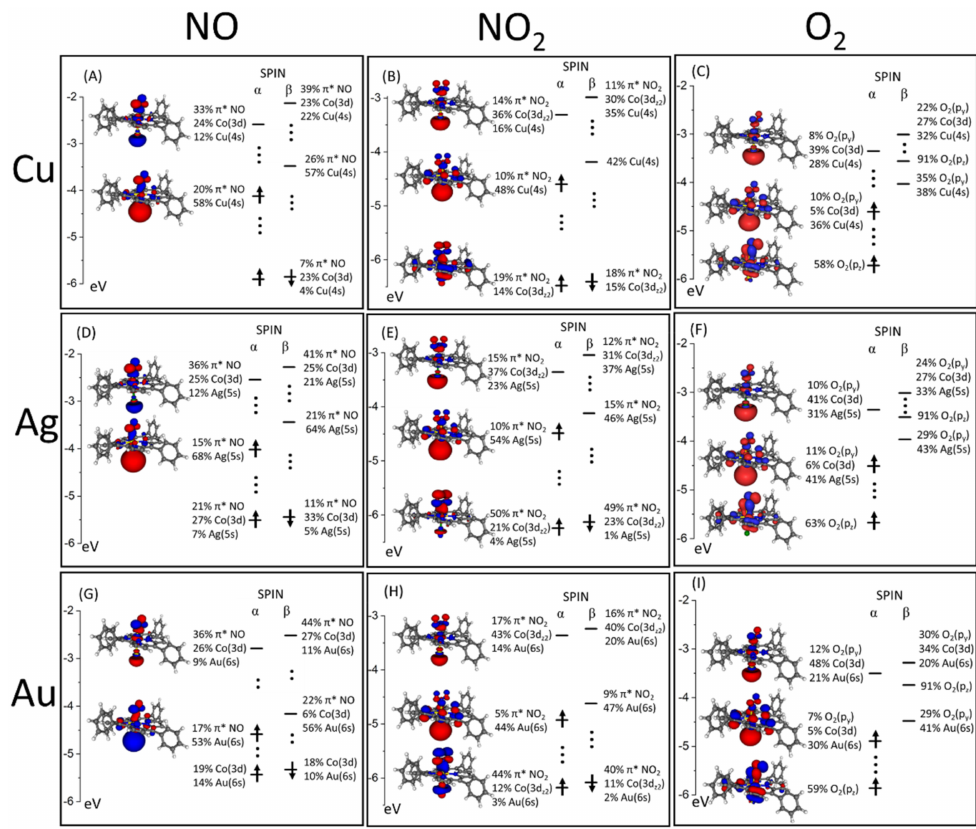
Figure 4. Energy level diagrams of selected frontier MOs of the MS–CoTPP–L clusters (( A ) MS = Cu, L = NO; ( B ) MS = Cu, L = NO 2 ; ( C ) MS = Cu, L= O 2 ; ( D ) MS = Ag, L = NO; ( E ) MS = Ag, L = NO 2 ; ( F ) MS = Ag, L= O 2 ; ( G ) MS = Au, L = NO; ( H ) MS = Au, L = NO 2 ; ( I ) MS = Au, L = O 2 ; displayed isosurfaces of 3D plots correspond to ± 0.03 e 1/2 × Å − 3/2 ). The energy position of levels mainly localized on the TPP macrocycle is indicated by vertical